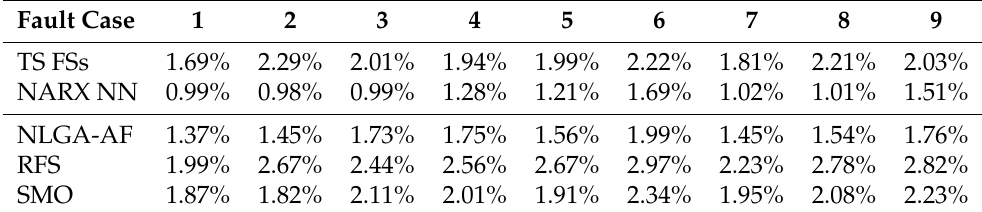
Table 7. RMSE % index for the HIL analysis and